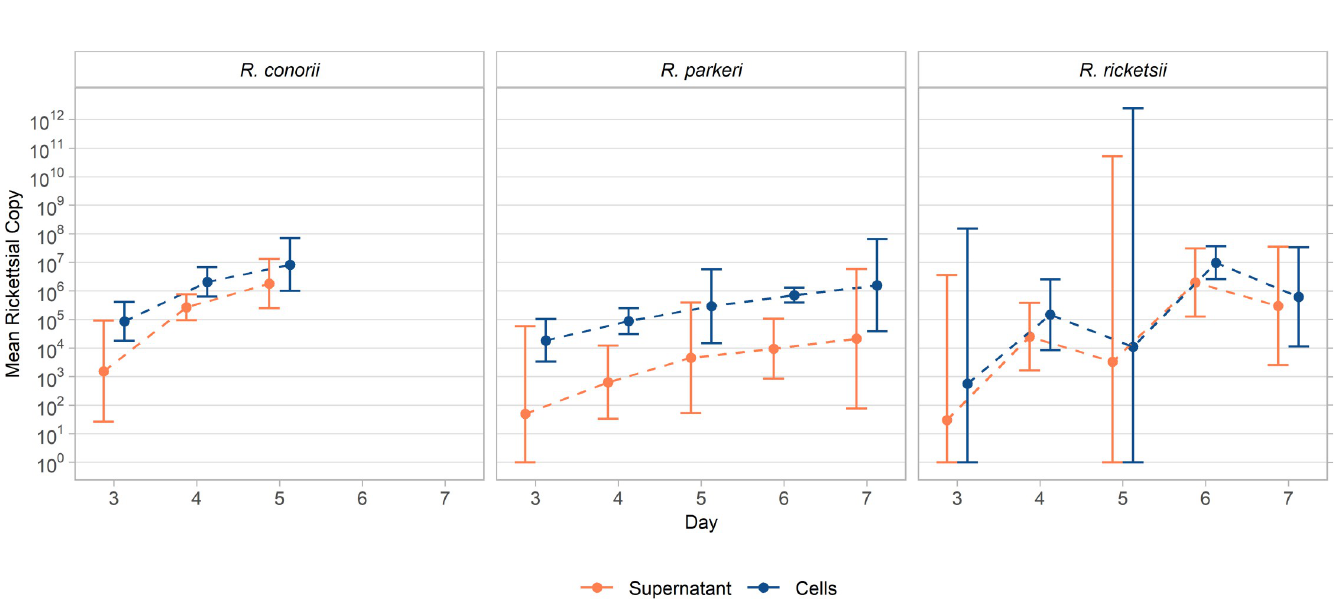
Fig 3. Comparison of average total copy number in supernatant accumulation and cellular amplification time course between SFGR